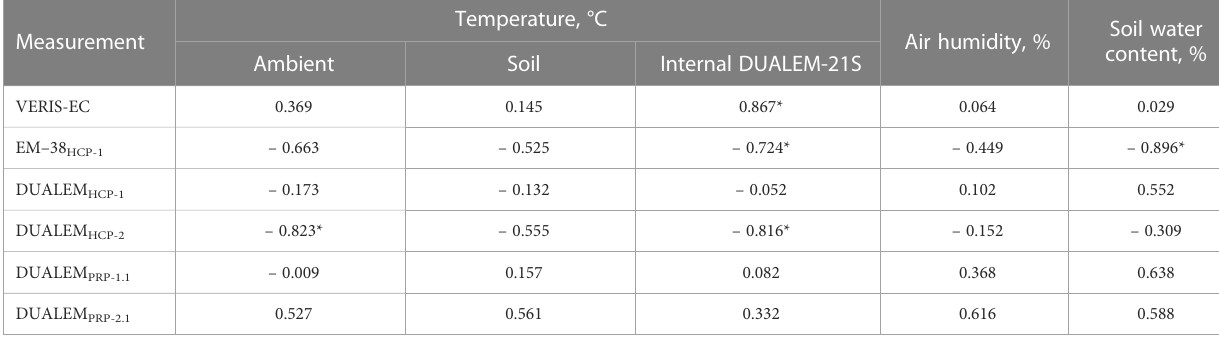
TABLE 5 Pearson coef fi cients of correlation between EC a measurements and measurement